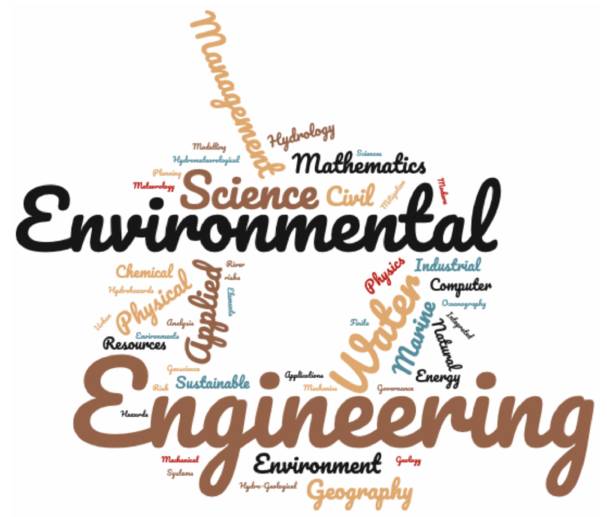
Figure 7. Word cloud indicating the subject areas in which WISE CDT students had obtained their highest entry qualification before entry to the